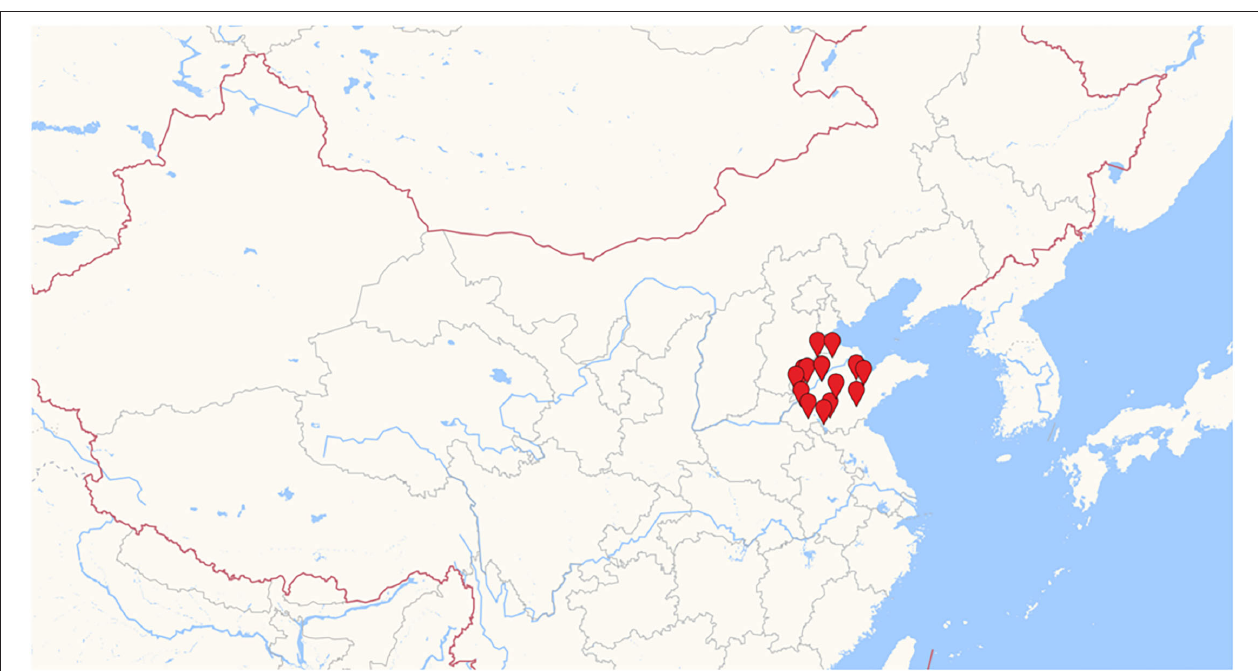
FIGURE 1 | Geographical distribution of the studied populations. Only individuals of Han Chinese ethnicity living in Shandong and the neighboring province were included, mitigating the effects of ethnic, dietary, and geographic differences on the results.